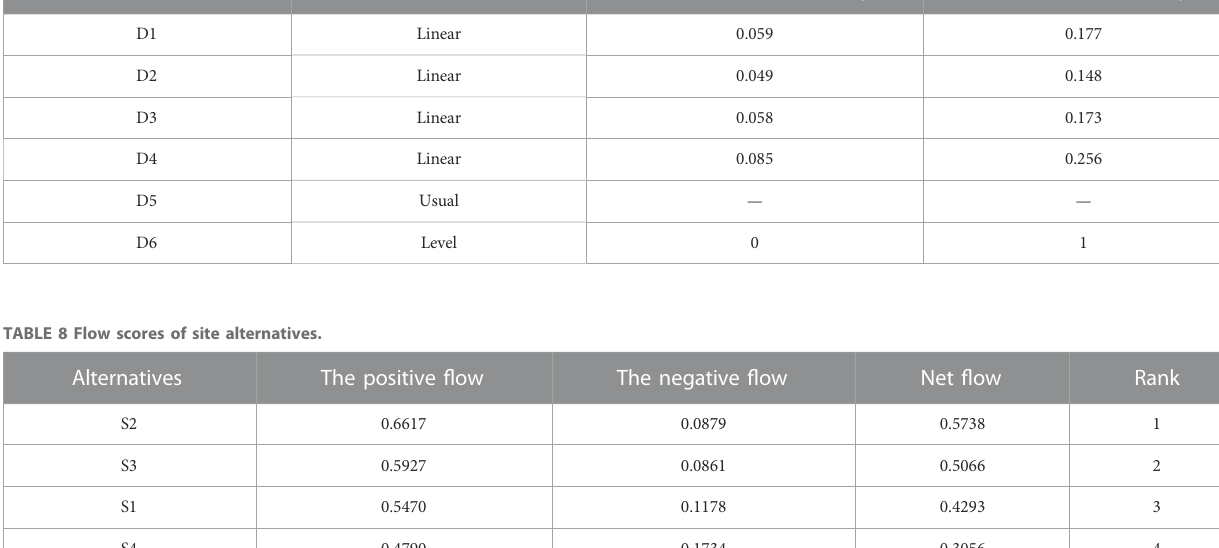
TABLE 7 Preference functions and thresholds of evaluation indices. Evaluation indices